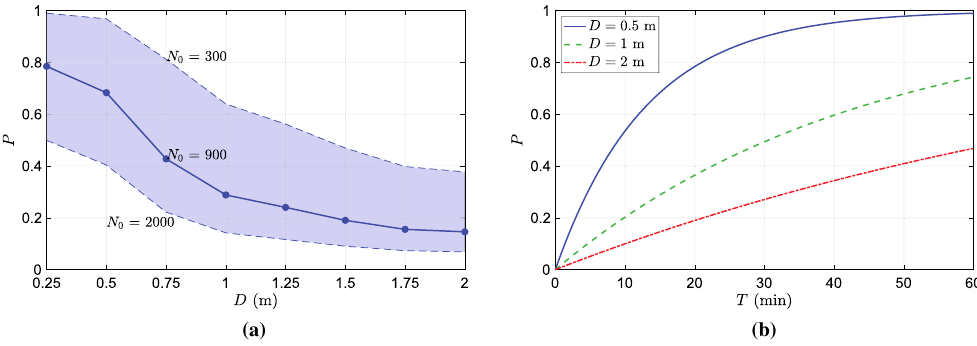
Figure 6. ( a )The probability of infection due to exposure for 15 mins plotted against distance during face-to- face conversation. ( b ) Evolution of P over time at distance of 0.5, 1.0, 2.0 m from the infection